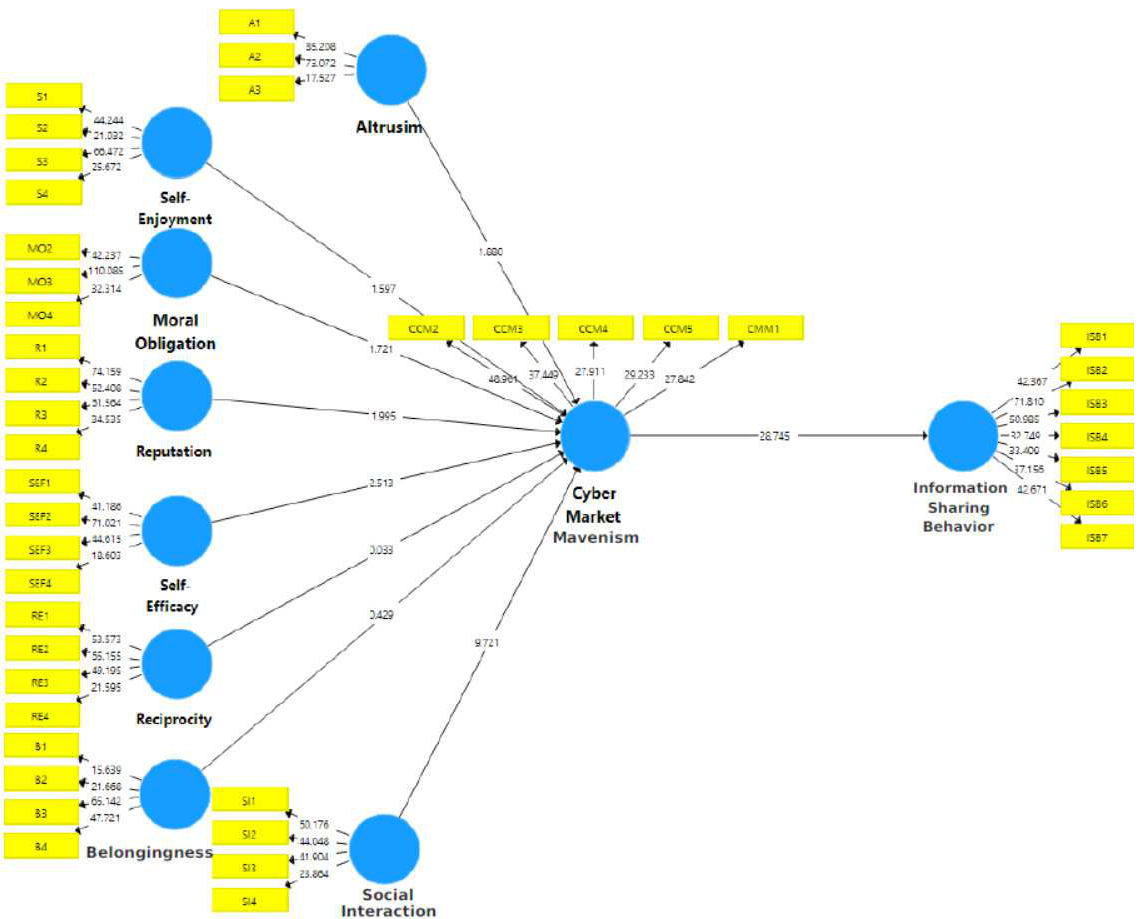
Figure 2. Estimated